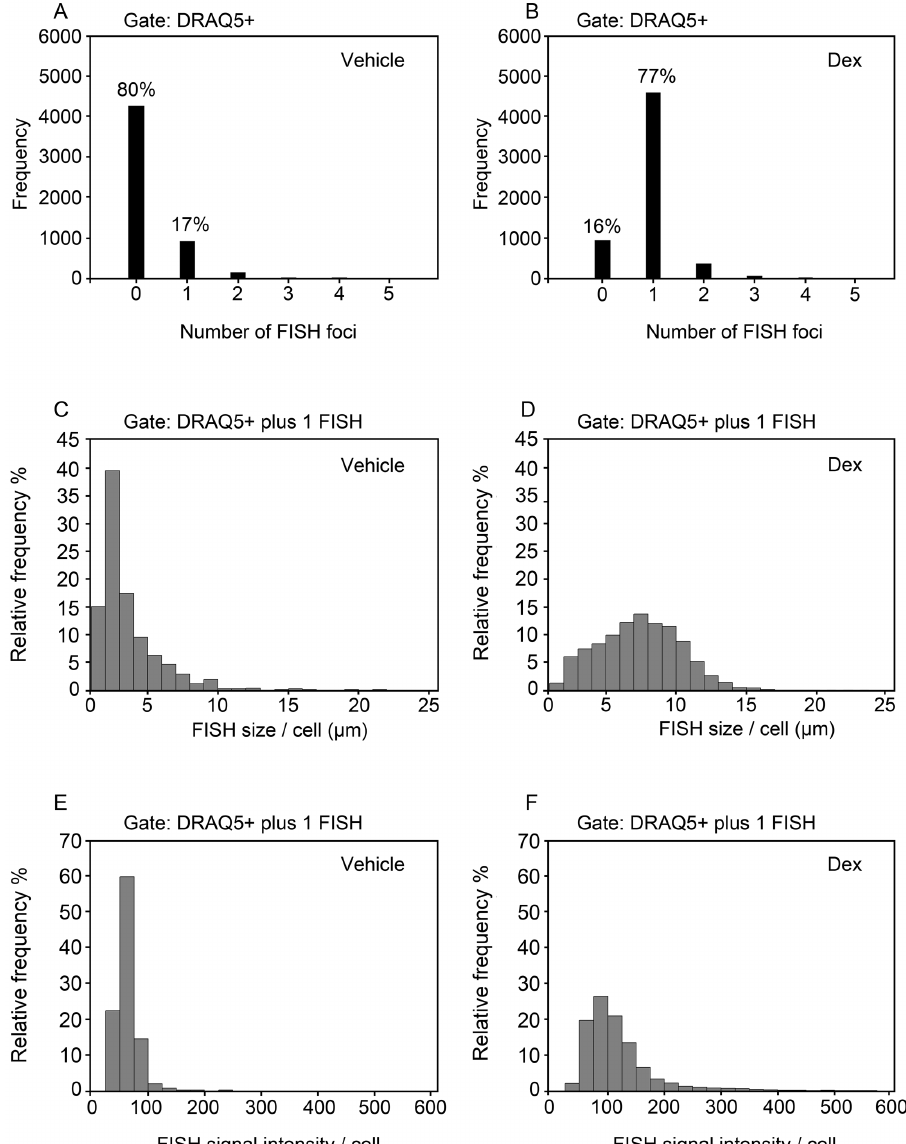
Figure 2. Hormone induction results in a heterogeneous MMTV-Ras transcriptional response in individual 3134 cells. (A, B) Frequency distribution of cells exhibiting 0, 1, or . 1 FISH signals following vehicle or dexamethasone treatment for 1 hr. (C-F) Relative frequency distribution plots of the variability in the RNA FISH signal size ( m m) (C, D) and FISH signal intensity (mean pixel intensity units) (E, F) detected in cells displaying 1 FISH signal following vehicle (n=899) or dexamethasone (n=4584) treatment.